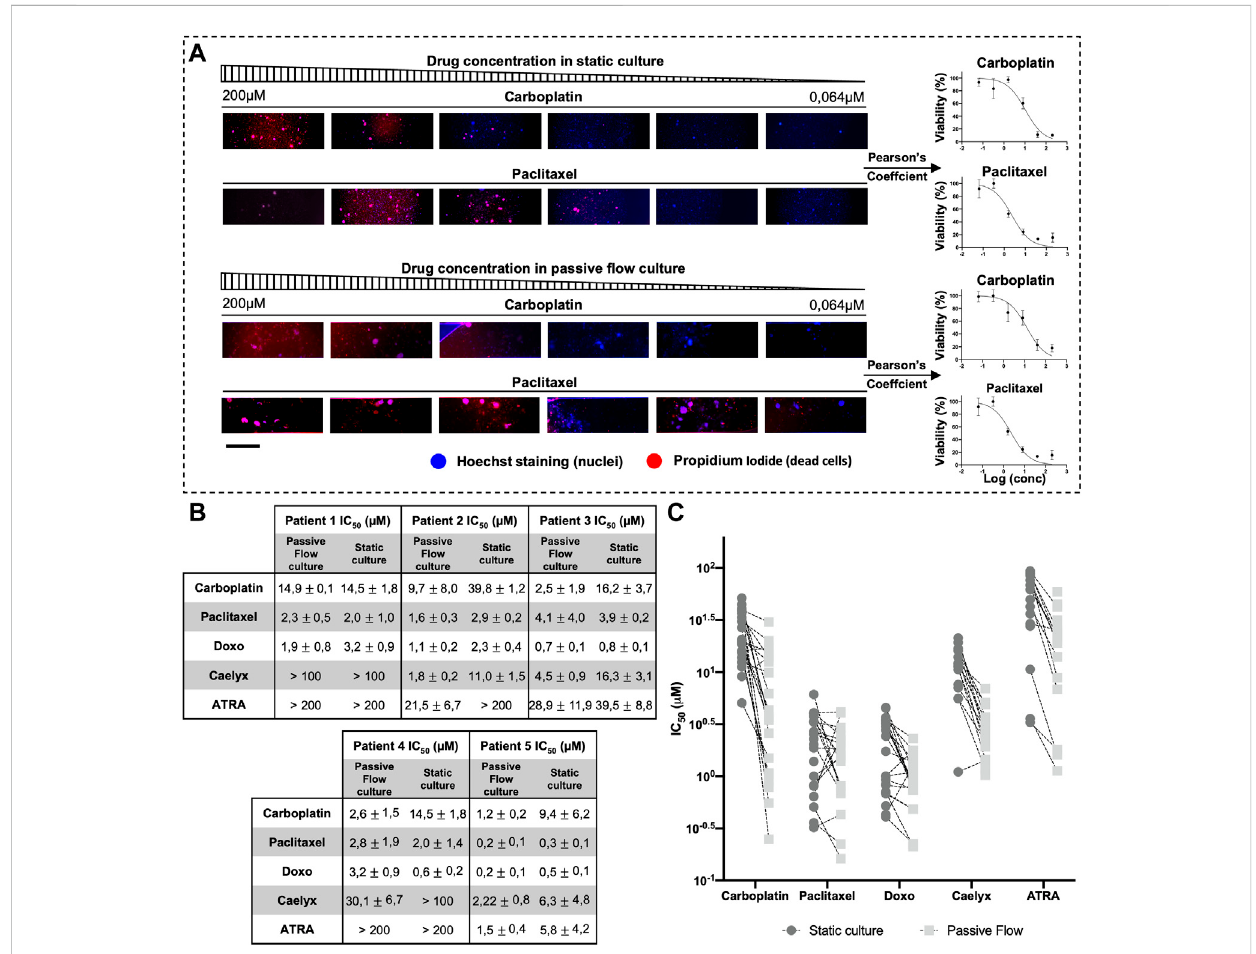
FIGURE 7 Half-maximal inhibitory concentration (IC 50 ). (A) An example scheme of the extrapolation of a dose-response curve from Propidium iodide and hoescht-stained organoids. Organoids were treated with serial dilution of carboplatin and paclitaxel. Pearson ’ s coef fi cient was calculated and used to generate the dose-response curve. (B) IC 50 Values ( μ M) of Carboplatin, Paclitaxel, Doxorubicin, Caelyx, and ATRA. Data were obtained from four replicates. The numbers represent the mean and standard deviation. (C) Graphical representation of all IC 50 valuesofall organoids divided by drugs. It is possible to observe how the values of IC 50 are generally smaller in the dynamic culture. Scalebar is 500 μ